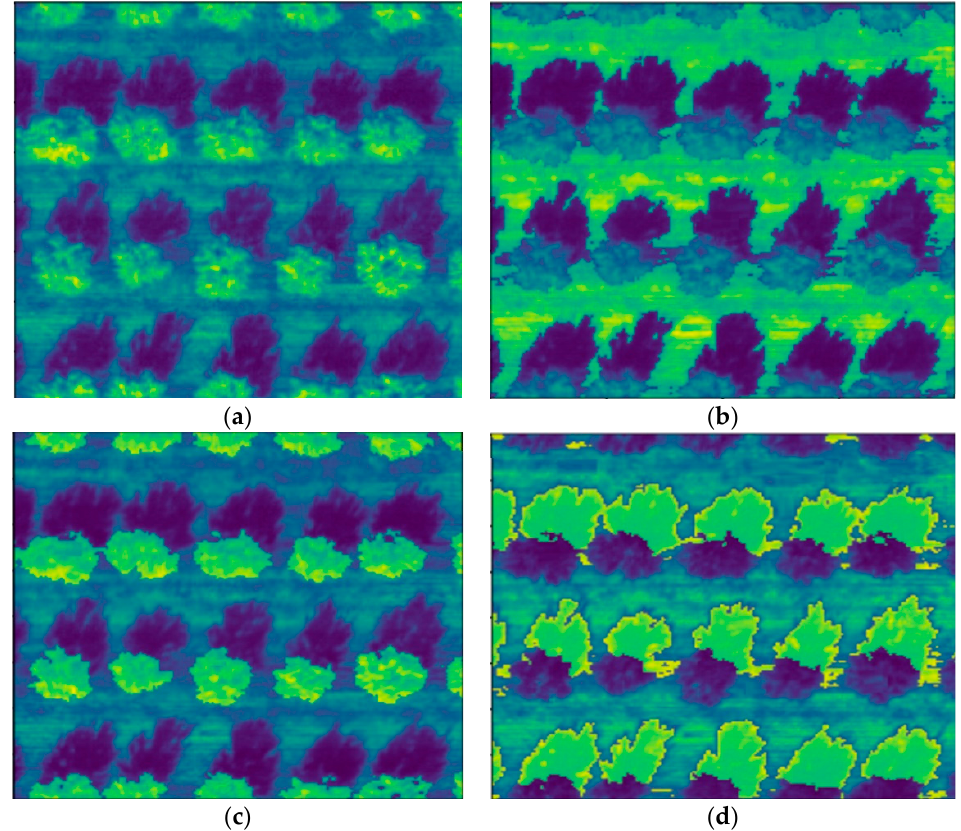
Figure 10. Visualization of Classification results based on different algorithm. ( a ) Reference; ( b ) ground; ( c ) tree; ( d ) shadow.